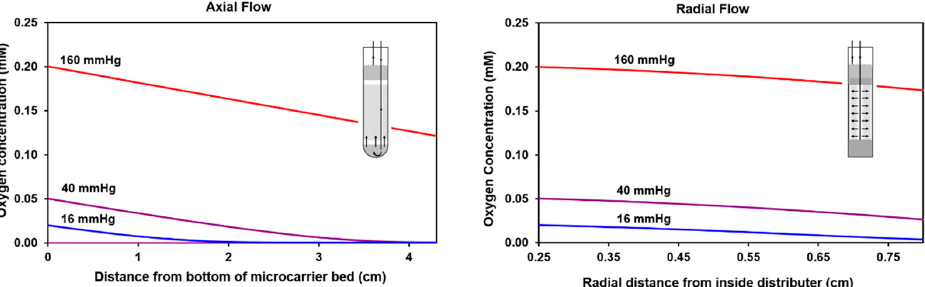
Figure 2. Calculated oxygen profiles for axial and radial flow across the length of the respective cell masses. The flow orientations in the NMR tubes are shown in the small schematic inserts. For both flow configurations, the cell density was assumed to be 1.4 × 10 7 cells/cm 3 and the oxygen consumption rate per cell was assumed to be 2.7 × 10 − 13 mmol/s/cell. With axial flow ( left ), the reduction in the oxygen level through the cell mass is much larger than it is with radial flow ( right ). At the lowest inlet level of 0.02 mM (gas phase 16 mmHg of oxygen), the oxygen is essentially depleted less than halfway to the top of the NMR tube with axial flow. In contrast, with radial flow, the oxygen level is more homogeneous and oxygen is available throughout the cell mass.